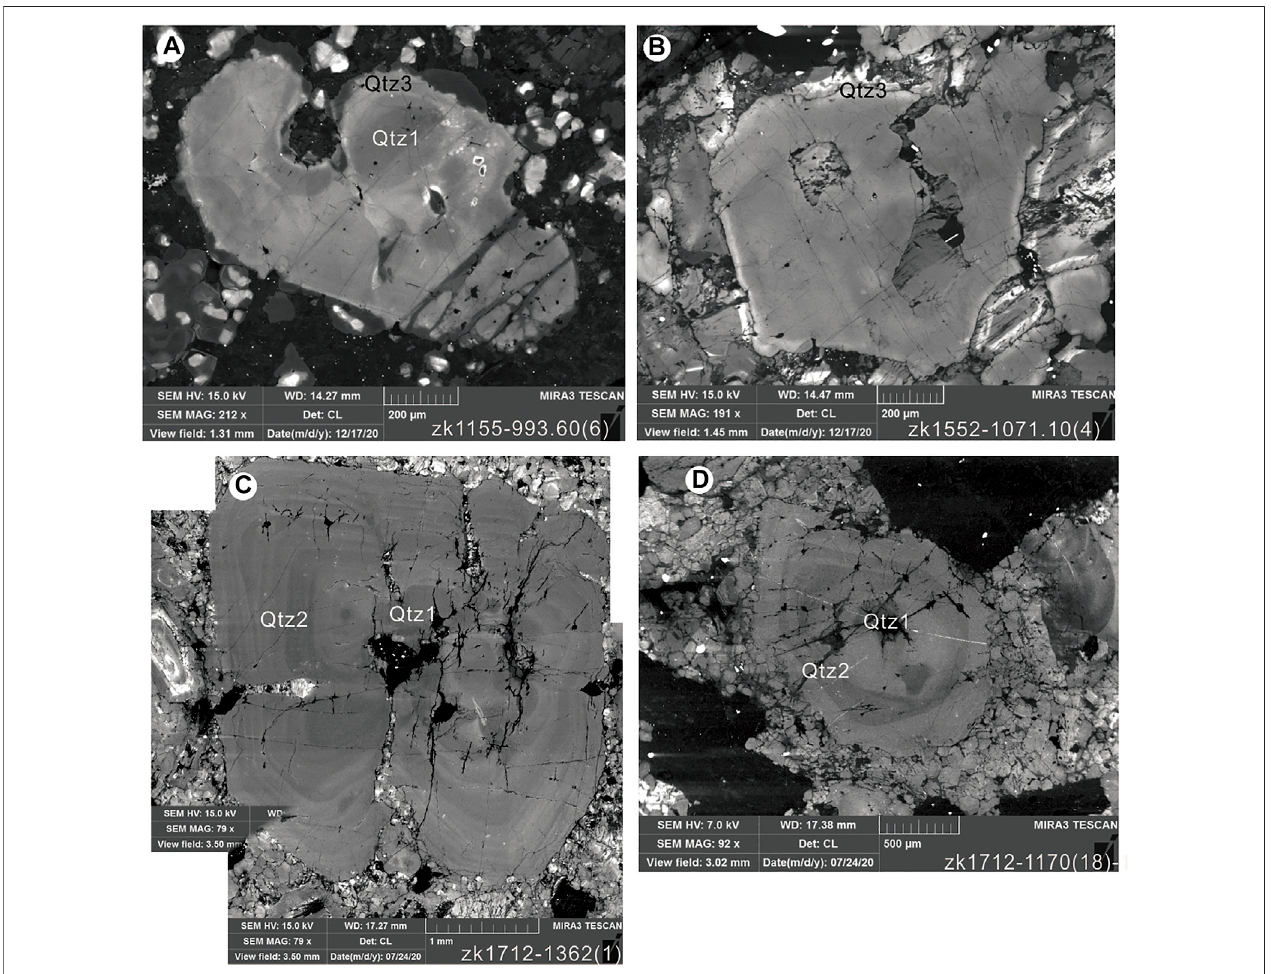
FIGURE 4 | SEM-CL image of quartz from the Hongniu – Hongshan deposit (for explanations of symbols, see Figure 3 ).